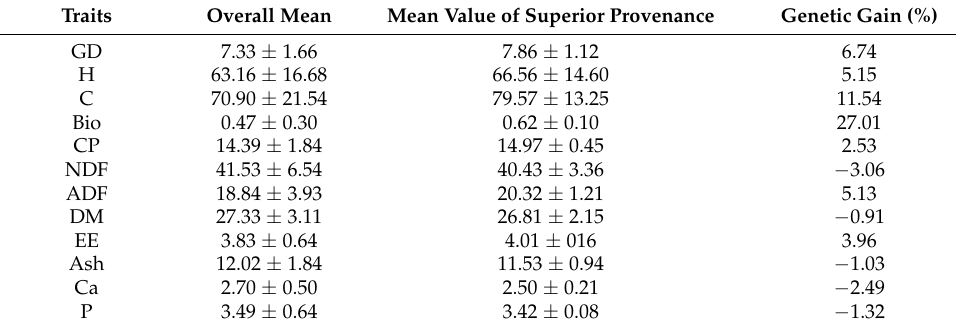
Figure 4. Selection of superiority provenance for feed type. Table 7. Genetic gain of each characteristic of the selected superior provenances. Table 7. Genetic gain of each characteristic of the selected superior